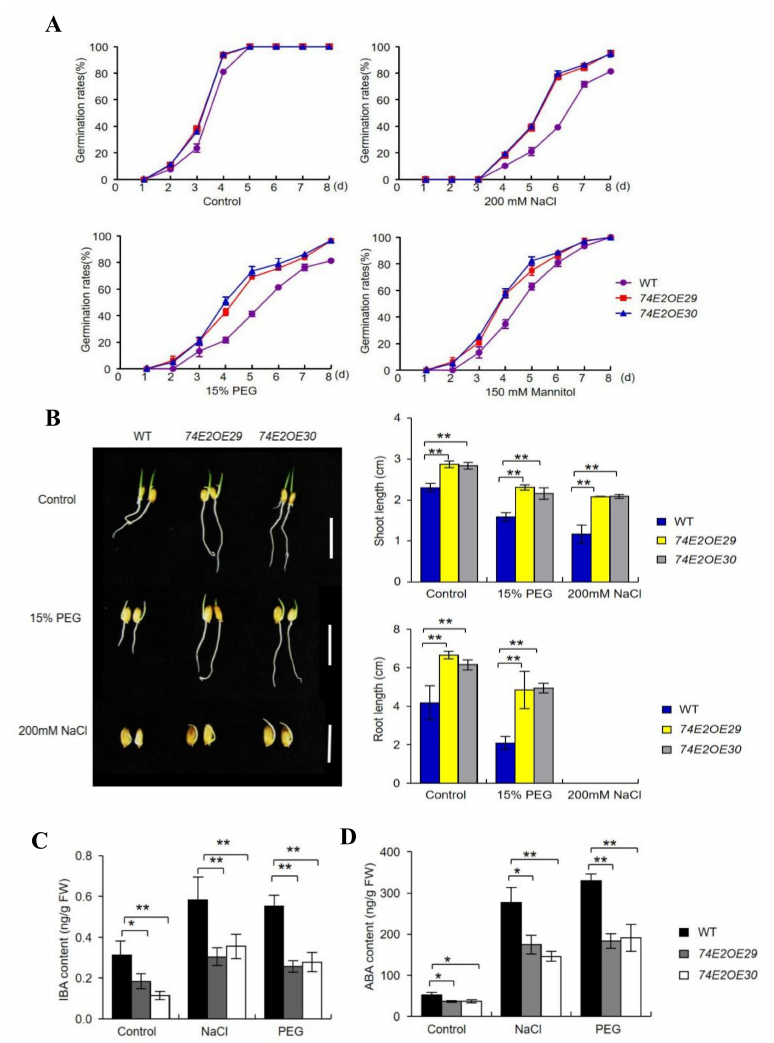
Figure 5. UGT74E2 transgenic lines are not sensitive to salt and drought stresses during the germination and postgermination stagea. ( A ) Germination rates of WT and UGT74E2 -overexpressed